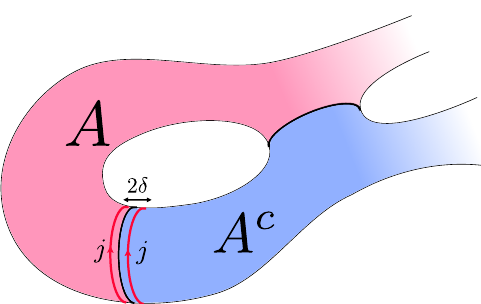
Figure 16 . In a homogeneous su (2) k theory, j and j uniquely fuse to the identity operator as (cid:14) 0. Thus Wilson loop operators acting the edge of A can be represented as an operator acting ! on the edge of A c